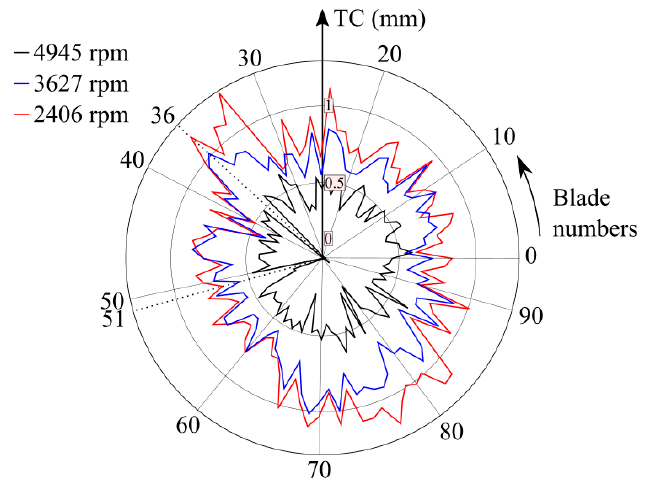
Figure 12. TC values of each of the 94 blades obtained with OS 3 at three different WPs.